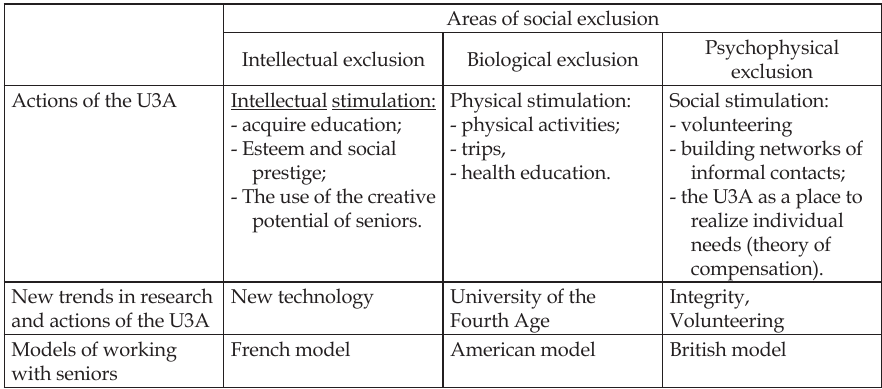
Tab. 1. The role of the Third Age University in counteracting the effects of social